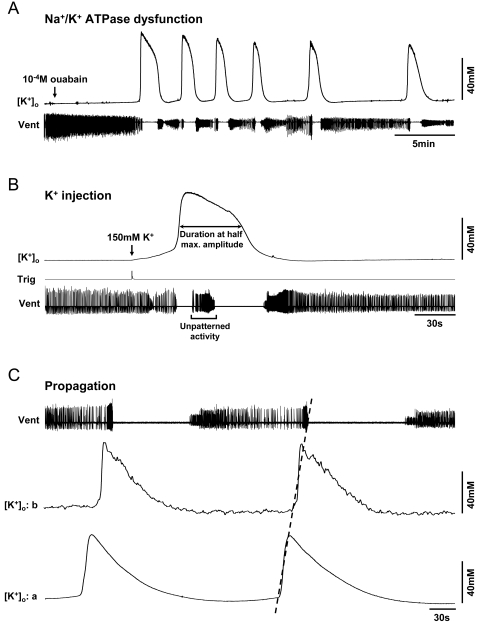
Characteristics of [K+]o surges.Simultaneous recordings of the ventilatory motor pattern (Vent), a monitor of pressure-injection of a bolus of K+ within the MTG (Trig in B) and the extracellular potassium concentration ([K+]o). A. Continuous bath application of 10−4 M ouabain elicited multiple surges in [K+]o (N = 13). In the experiment shown here it took 434 seconds for 10−4 M ouabain to penetrate the MTG and induce failure of motor pattern generation. B. A 35 nl pressure-injection of locust saline containing a 15-fold higher [K+] (150 mM compared to 10 mM) into the MTG neuropile was sufficient to bring [K+]o to threshold and induce an abrupt surge (N = 18). C. Two K+ -sensitive microelectrodes were inserted in different regions of the MTG (a and b) to illustrate propagation (dotted line). In this experiment the propagation speed was 1.9 mm/min.